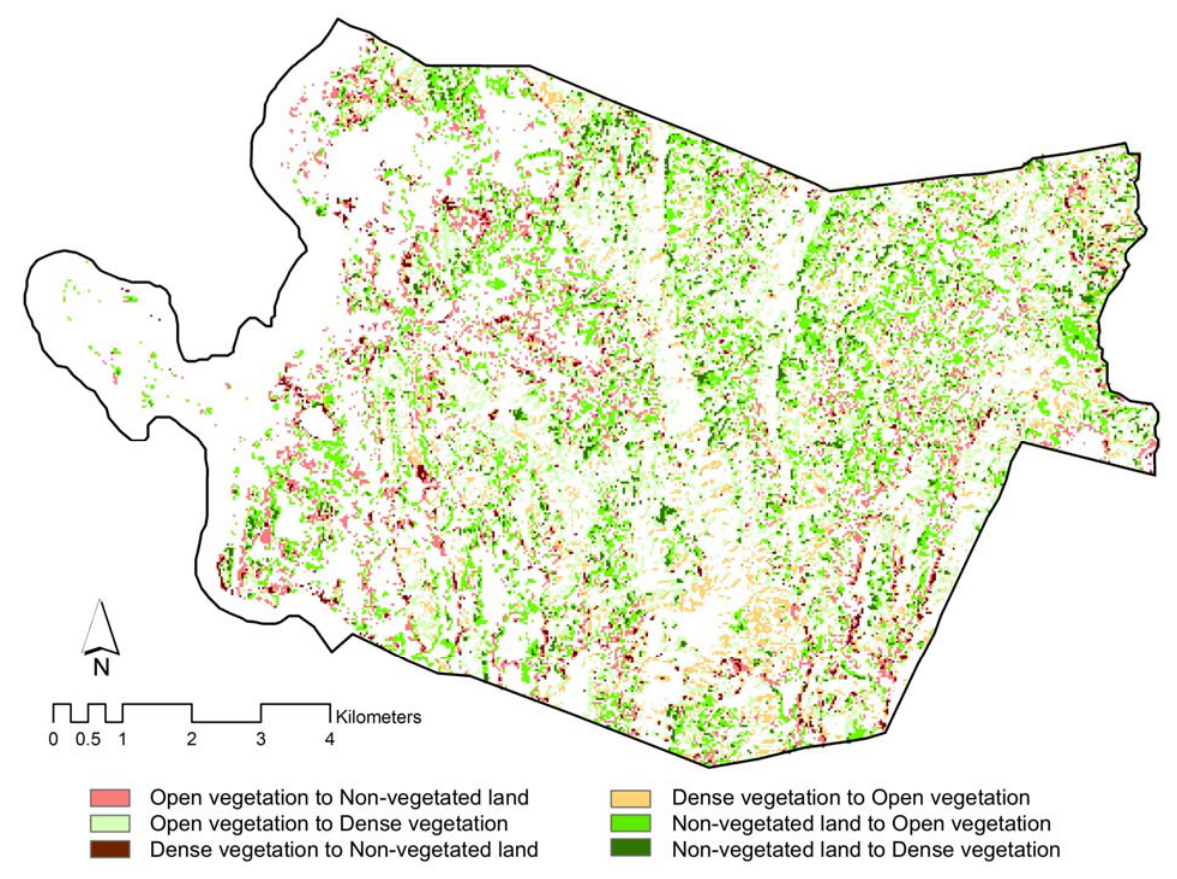
Figure 6. Major vegetation covers conversions, 1989–2009.